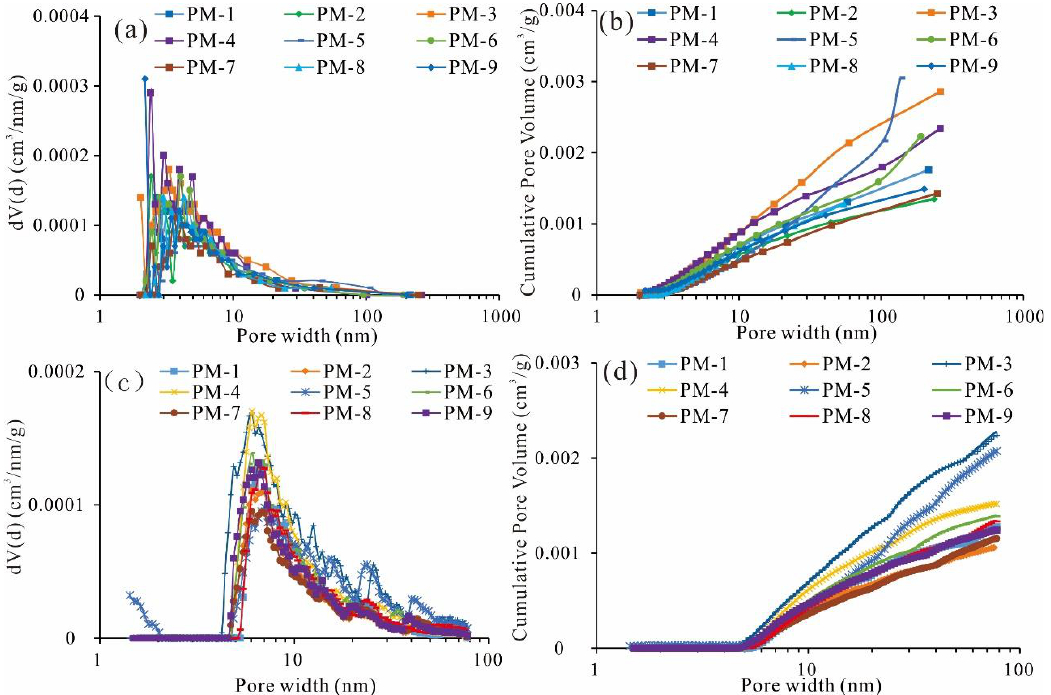
Figure 6. Distribution of the PV calculated by the BJH and NLDFT models. ( a , b ) BJH model, ( c , d ) NLDFT model. Table 3. Pore analysis results of the BJH and NLDFT models.